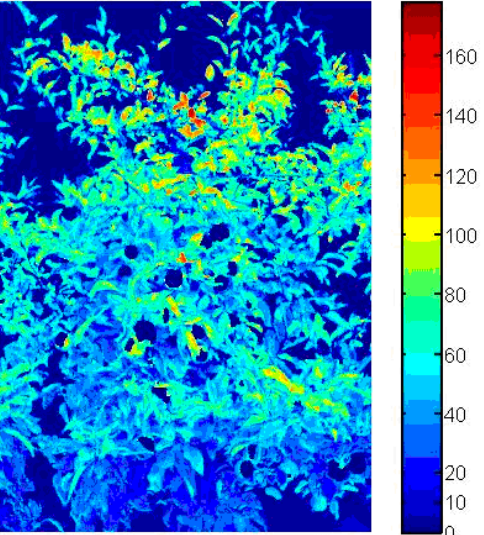
Figure 5. Example of an image of an apple tree with colour-coded mapping of colour differences between G (green) and B (blue) for each pixel, showing the leaves as bright colour dots and the background in deep blue.